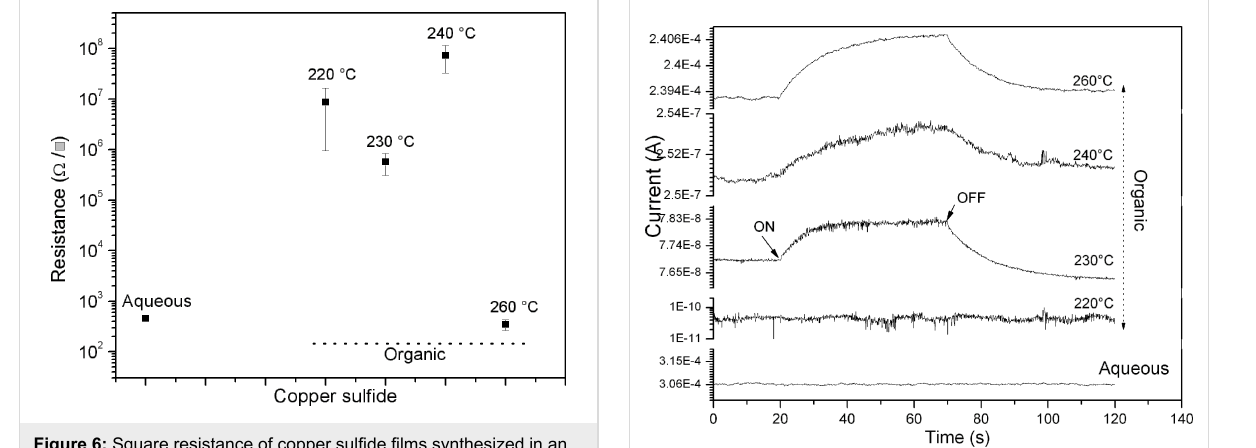
Figure 6: Square resistance of copper sulfide films synthesized in an aqueous solution (left) and in organic solution (right). The samples with low electrical resistance are amorphous Cu x S obtained from aqueous solution and crystalline Cu x S synthesized at 260 °C. slightly photosensible, suggesting a photo-generation of carrier charges. The current increases gradually as a function of the time exposed to the light, this is attributed to the recombination of charges due to the superficial states in the Cu x S samples.